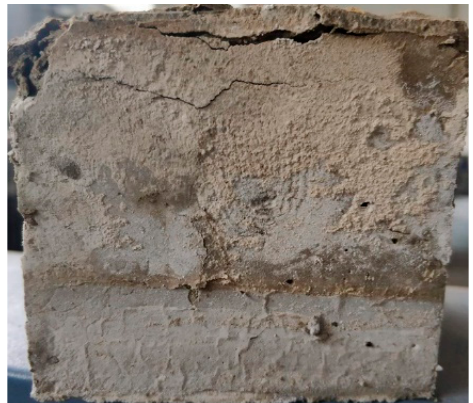
Figure 5. Surface morphology of samples at 65 °C for 28d.